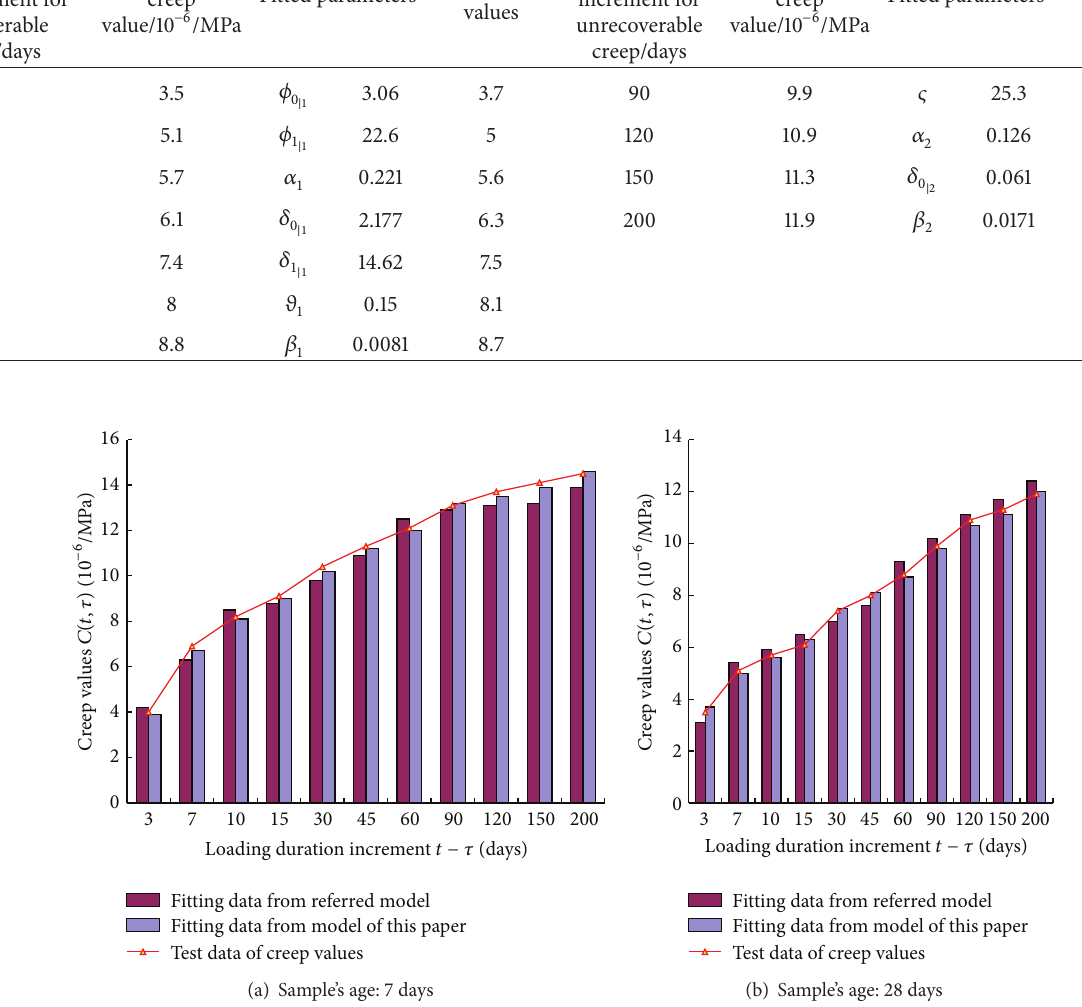
Figure 12: Comparisons of simulation accuracy of thermodynamic creep